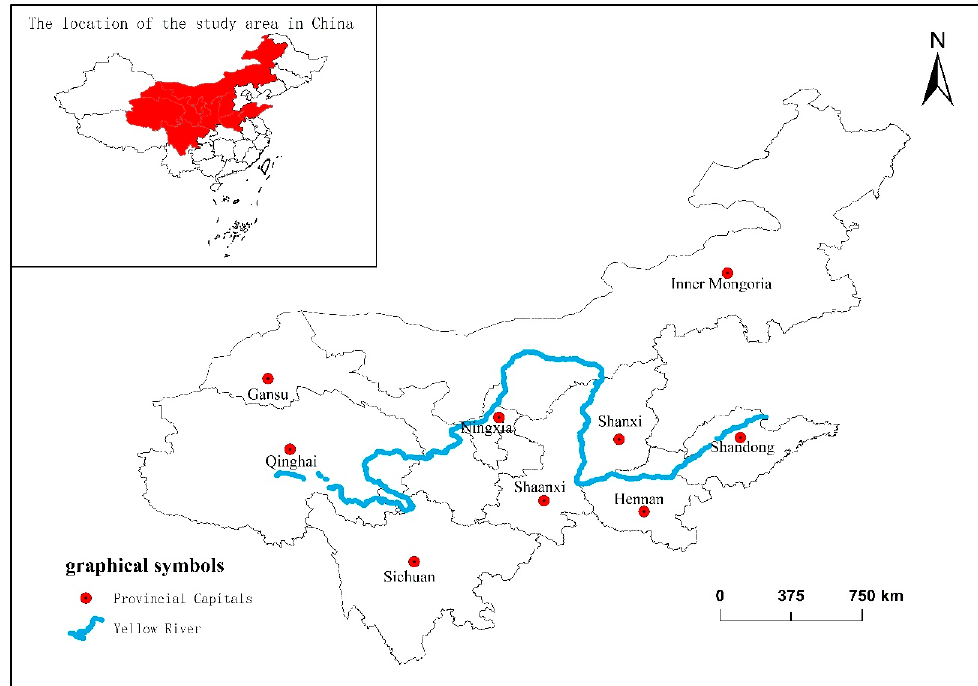
Figure 1. Administrative division map of the study area.